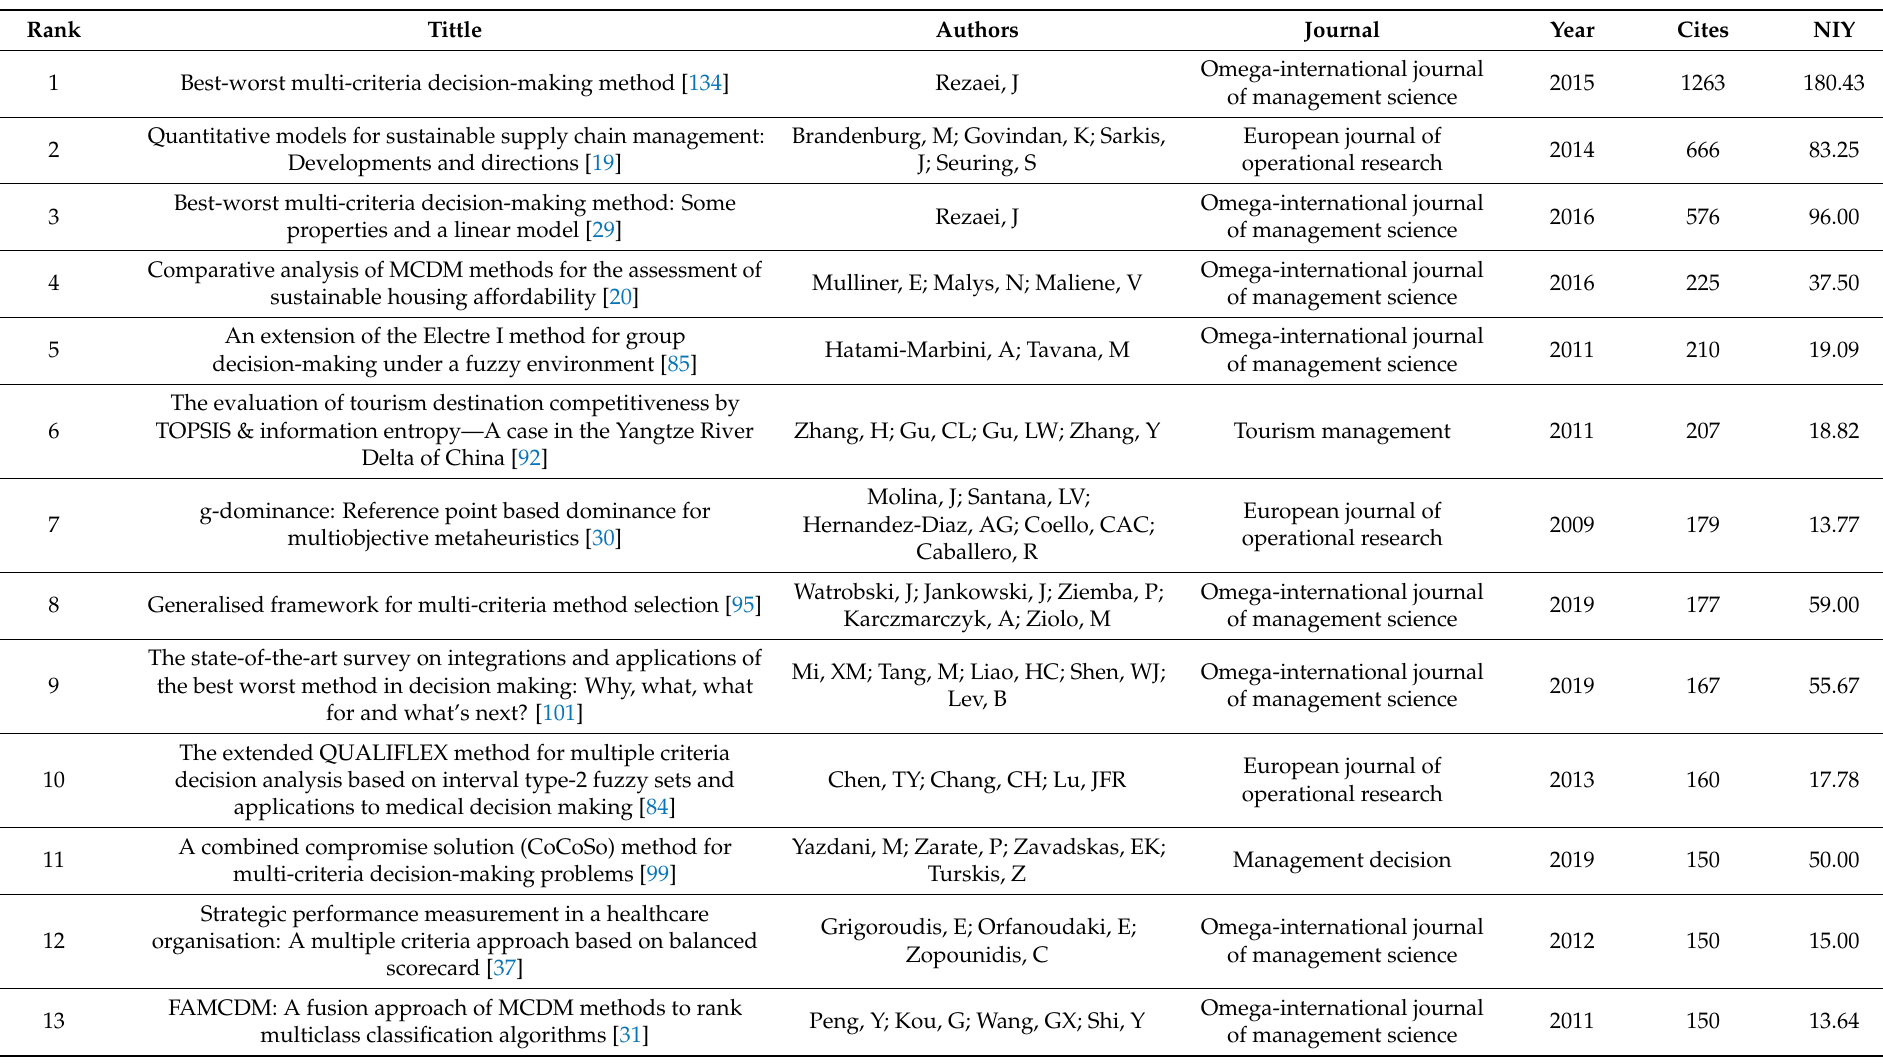
Table A2. Top 25 articles by citations. Subperiod 2